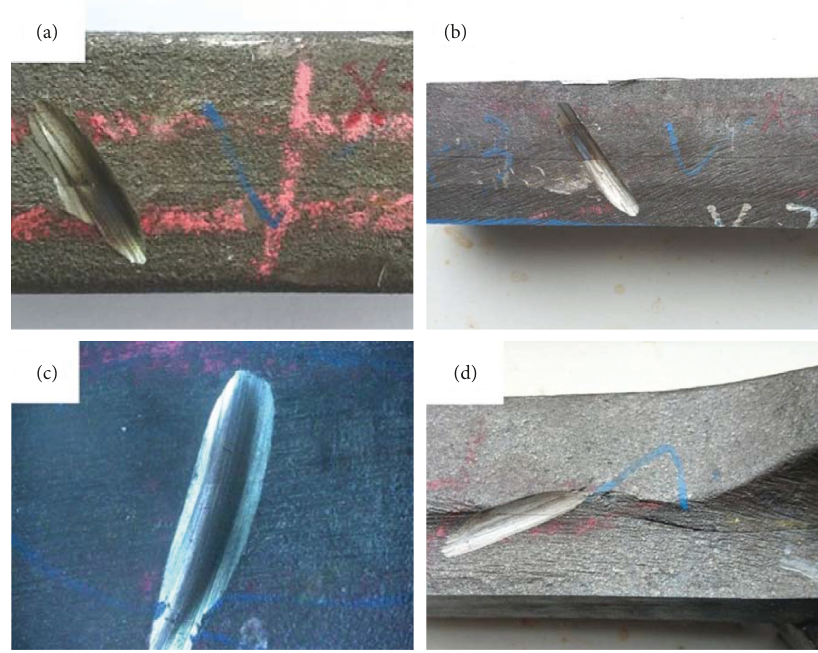
Figure 5: The macroscopic morphology of cracks. (a) Sample X -1. (b) Sample X -3. (c) Sample Y -1. (d) Sample Y